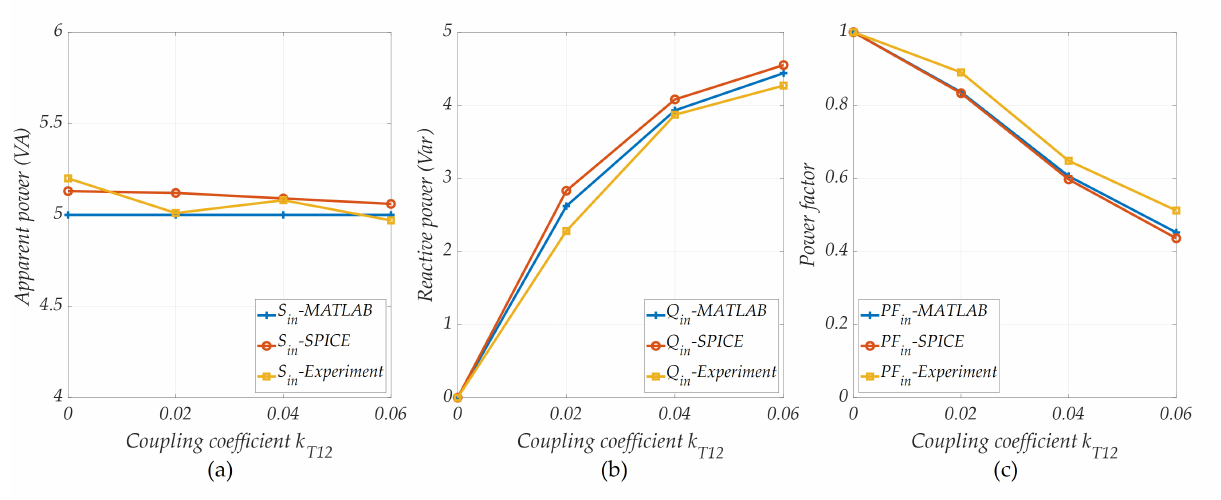
# » V bf : ( a ) S in , ( b ) Q in , and ( c ) PF in T